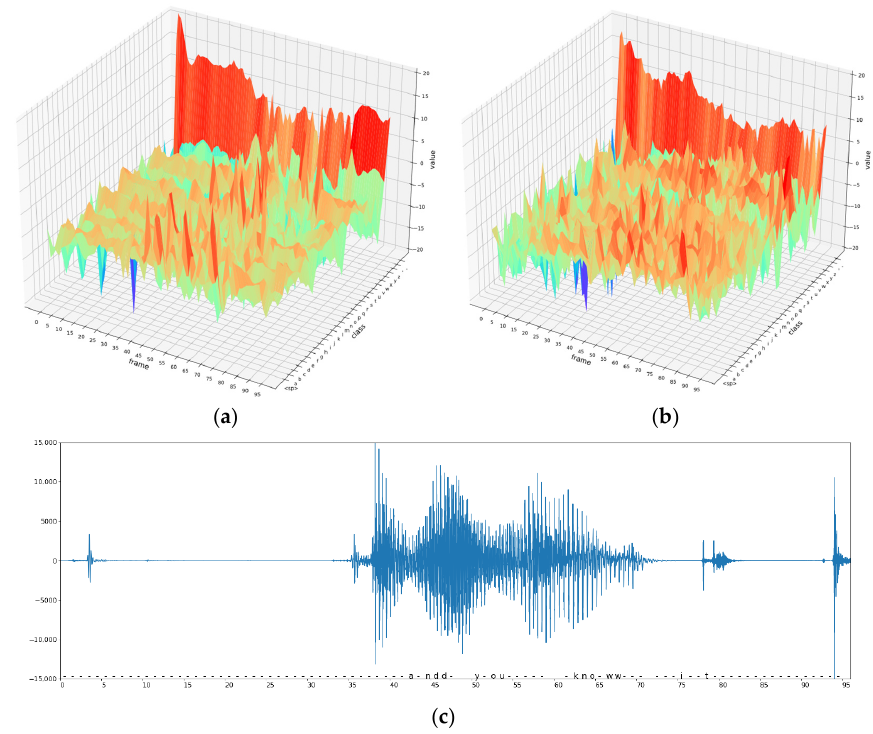
Figure 3. Logits of the original speech ( a ), adversarial example ( b ) and raw speech signal ( c ). To quantify this difference numerically, Park N et al. proposed a detection method based on the “distribution of the difference between the maximum value of logit and the second largest value” by adding Gaussian noise to the logits. Their method assumes that frames with a minor difference are more susceptible to maximum bit reversal when the noise follows the same distribution, leading to altered transcription results. As shown in Figure 3, the speech with more altered transcriptional effects after adding noise is more likely to be an adversarial example. After calculating the number of erroneous characters caused by adding noise to the logit, the error threshold can be determined at a statistical level, and speech adversarial example detection independent of the network structure is implemented. This paper defines the degree of disparity between the values of the classes in the “decision frame” of logits as the logit dispersion. In dense logits, it is sufficient to calcu- late by the values of “decision frames” that have the potential to affect the final tran- scription result. However, in sparse logits, the values of the “blank” pseudo-characters class in all “decision frames” must be removed. 3.3. Logits-Traction Adversarial Example Generation 3.3.1. Inspiration In computer vision, the C&W L2 attack [31] for the image classification task sets the confidence in the one-dimensional logit sequence to calculate the intra-frame difference feature. The loss term to perform the targeted attack is: 𝑓(𝑥 (cid:4593) ) = 𝑚𝑎𝑥(𝑚𝑎𝑥(cid:4668)𝑍(𝑥 (cid:4593) ) (cid:3036) :𝑖 (cid:3405) 𝑡(cid:4669) − 𝑍(𝑥 (cid:4593) ) (cid:3047) ,−𝜅)